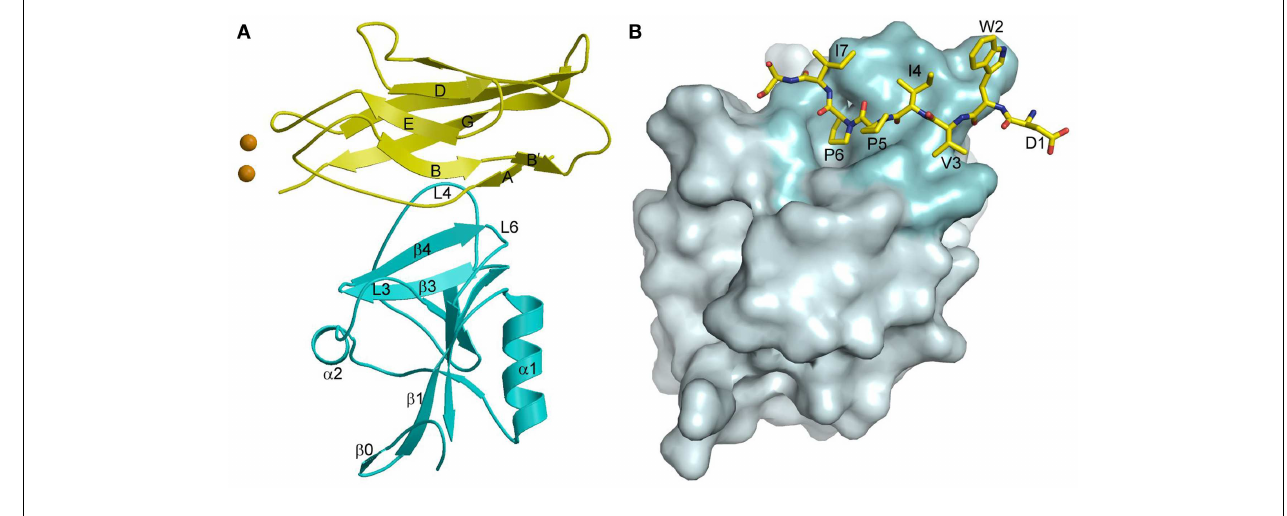
spheres. (B) The KLRG1–E-cadherin binding interface.The KLRG1 molecular surface is shown in gray with the region contacting E-cadherin colored cyan. Residues 1–8 of E-cadherin are drawn in stick format and